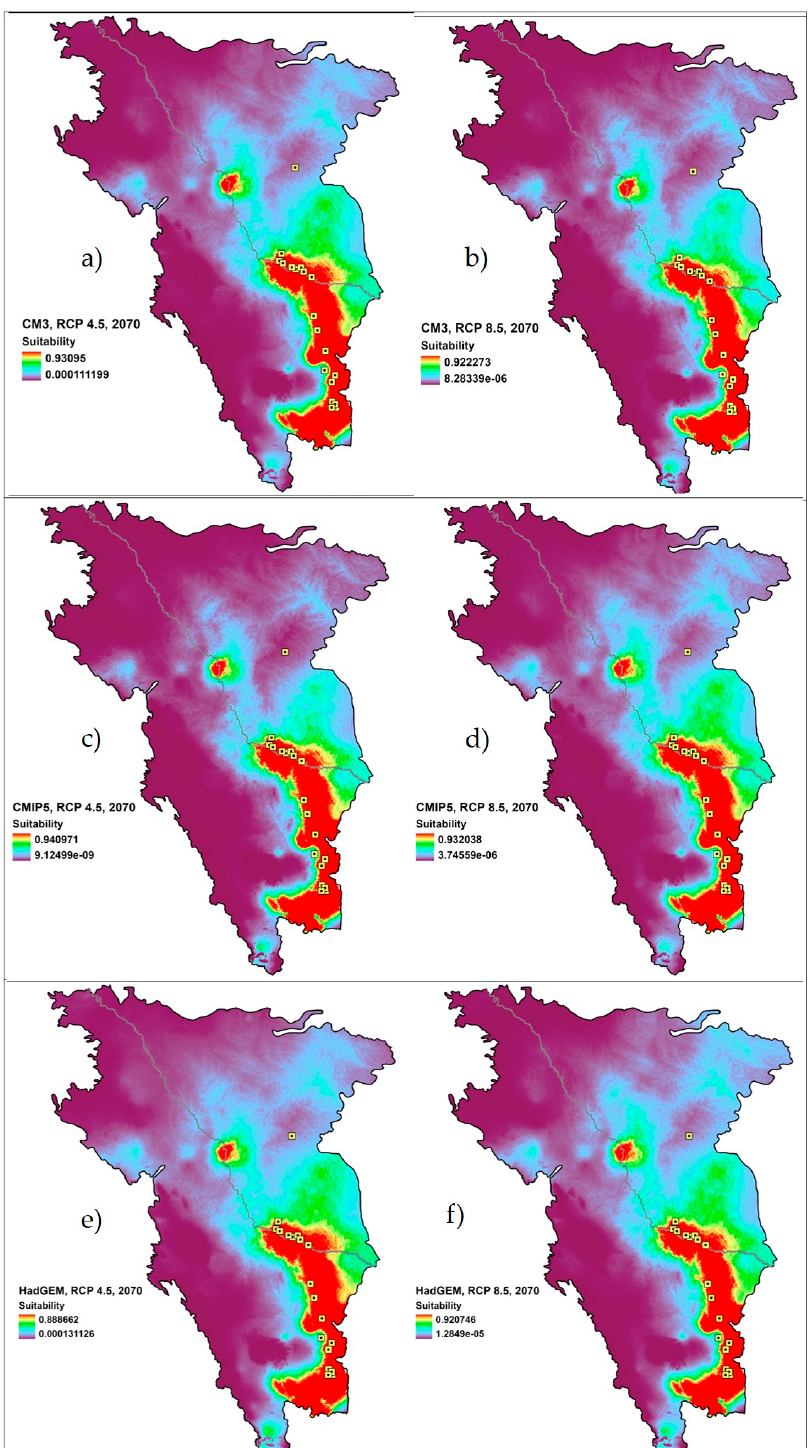
Figure 4. Future potential geographic distribution for M. walkerae for the year 2070 using ten bioclimatic variables and nineteen spatially rarefied occurrences. Panels ( a ) and ( b ) correspond to the CM3 GCM at an RCP of 4.5 and 8.5, respectively. Panels ( c ) and ( d ) correspond to the CMIP5 GMC at an RCP of 4.5 and 8.5. Panels ( e ) and ( f ) correspond to the HadGEM GMC at an RCP of 4.5 and 8.5.